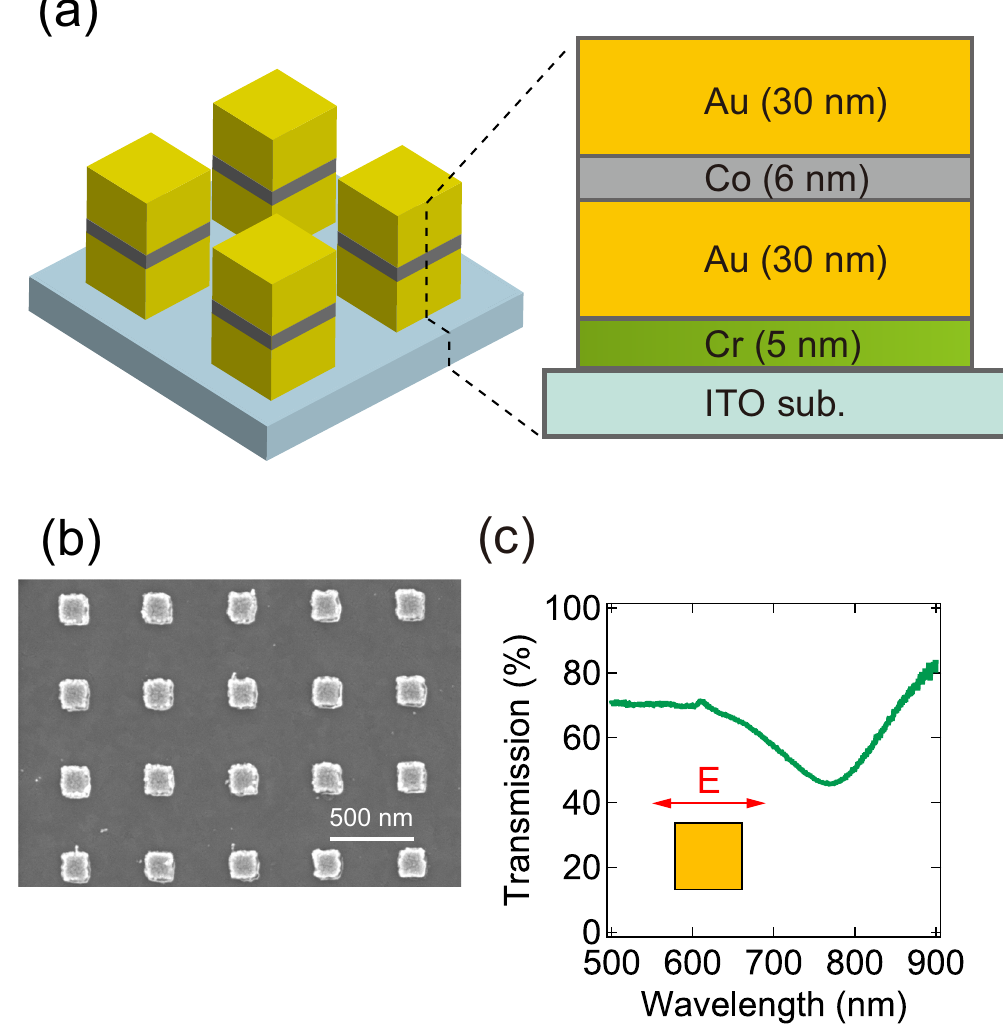
Figure 1. ( a ) Schematic of the fabricated nanostructure and the stacking structure of the thin film (cross- section view). ( b ) SEM image of fabricated Au/Co/Au nanostructures. ( c ) Transmission spectra of Au/Co/Au